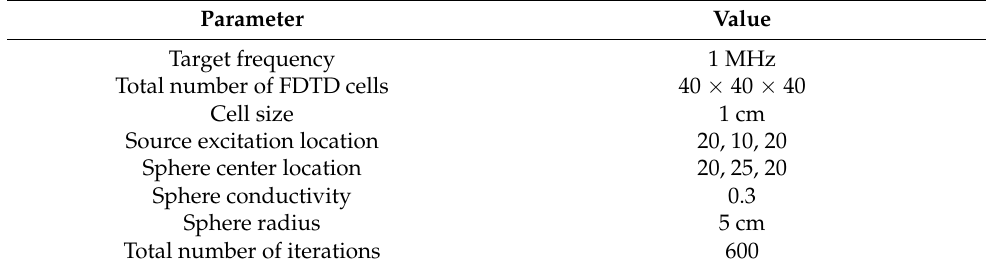
Table 1. Simulation